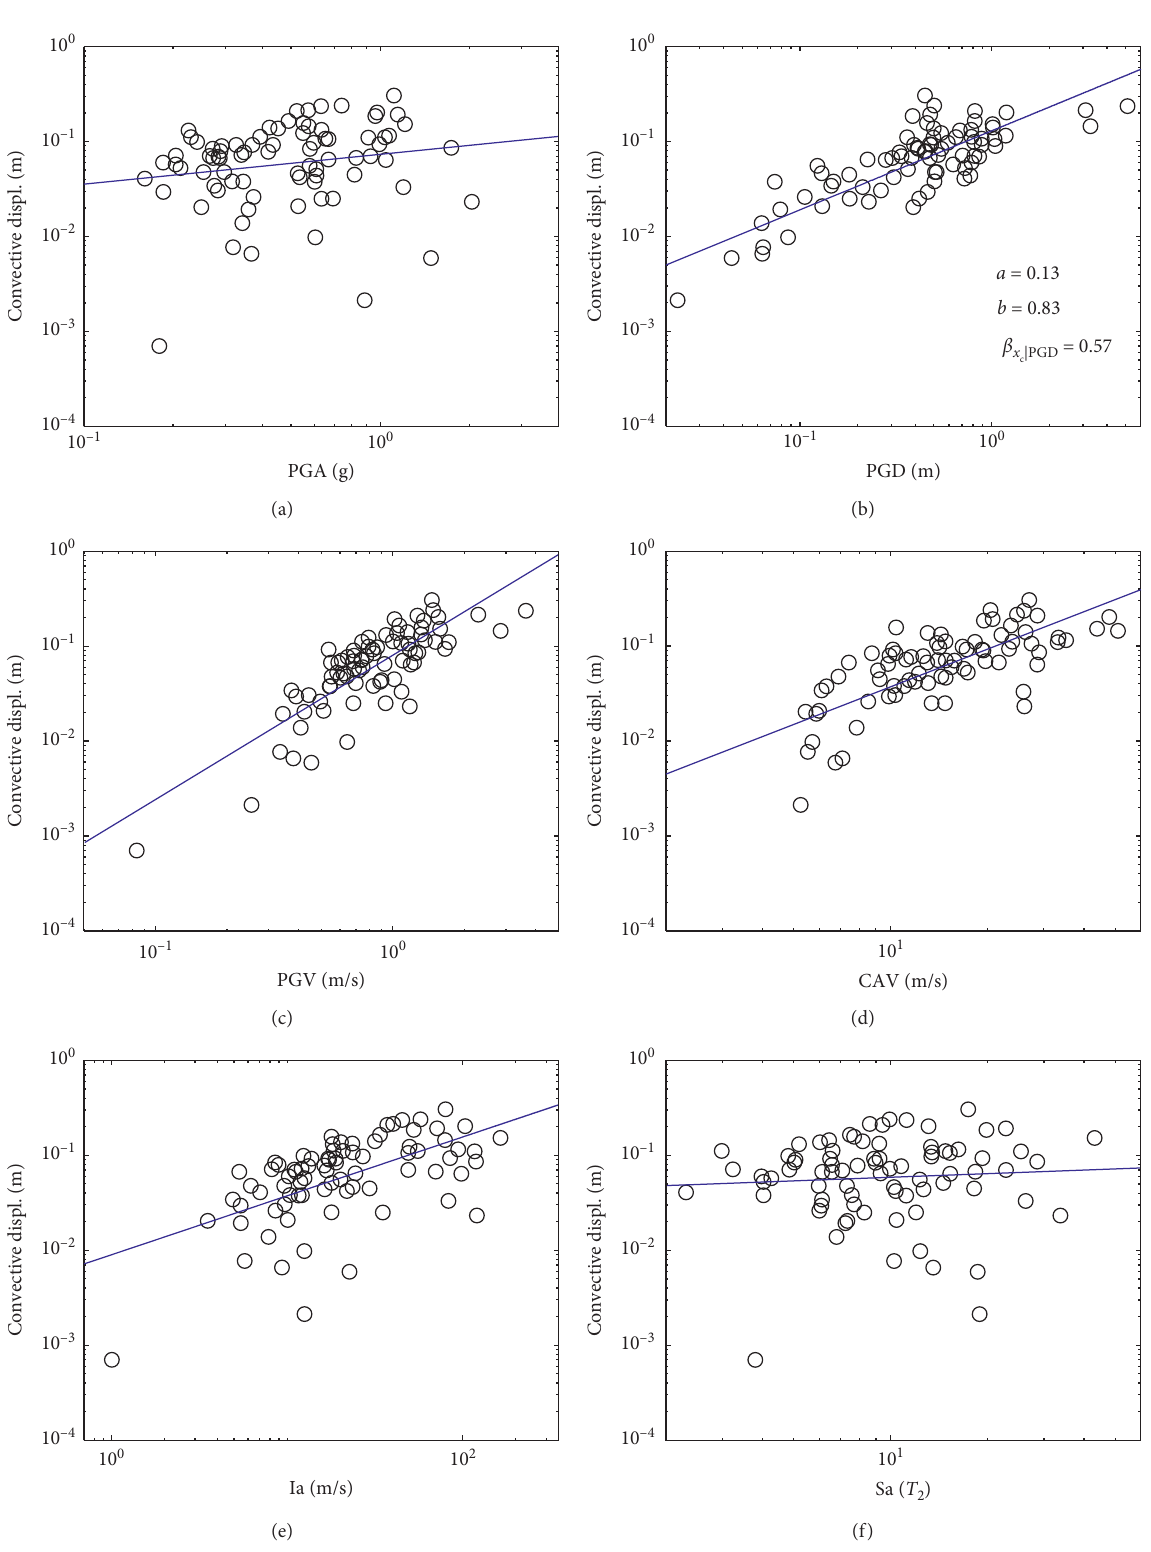
Figure 6: Linear fit demand model of convective displacement with different intensity